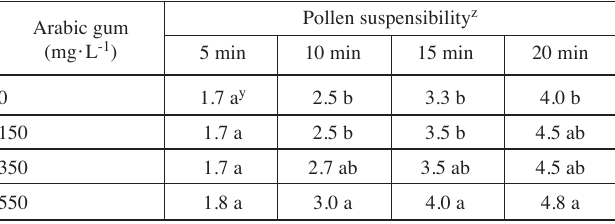
Tab. 3: Effect of arabic gum concentrations in pollen liquid diluent on the suspensibility by sensory evaluation of ‘Matua’ kiwi pollen.